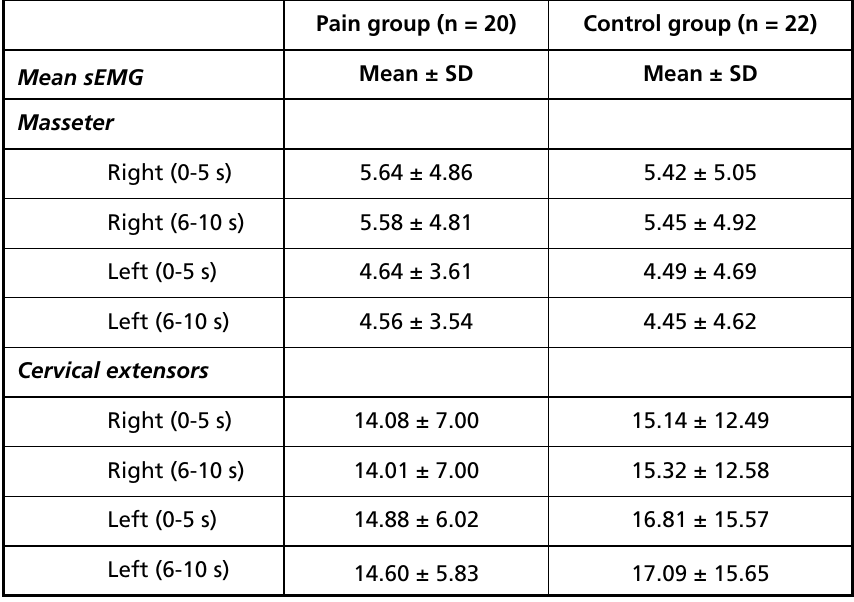
table 3: surface eMG data of masseter and cervical extensors during light teeth contact (n =